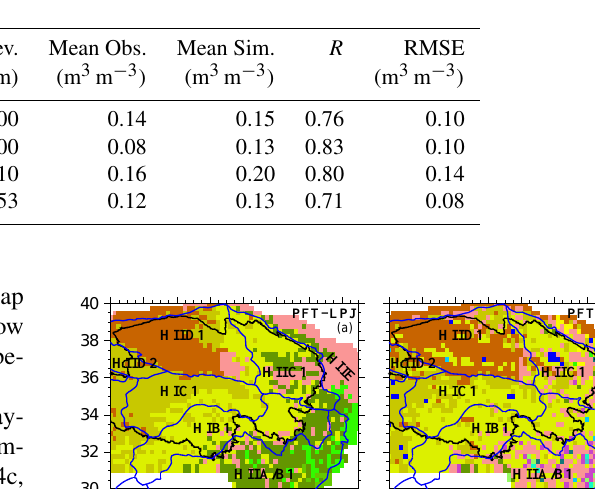
Piao et al. (2012) in that the increase trends prevail in the northeast and the south of the NTP and more widely spread than those of the total FPC. These similarities further